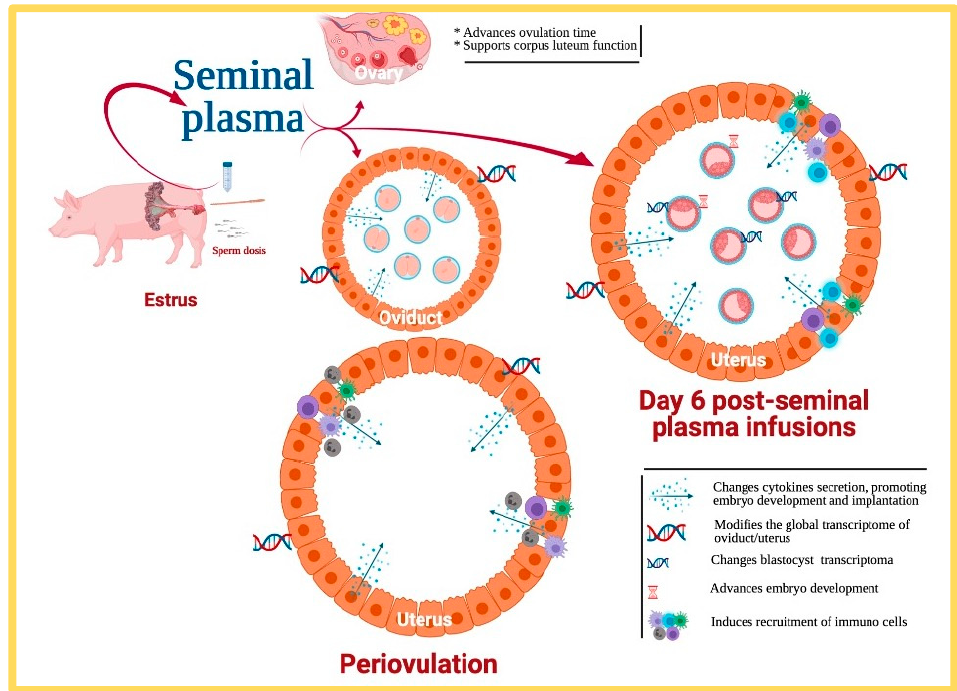
Figure 6. Infusions of additional sperm-free pig seminal plasma during estrus causes a plethora of functional effects in the female, from advancing ovulation, supporting corpora lutea development, to a significant number of events six days later, at the oviduct and uterus.